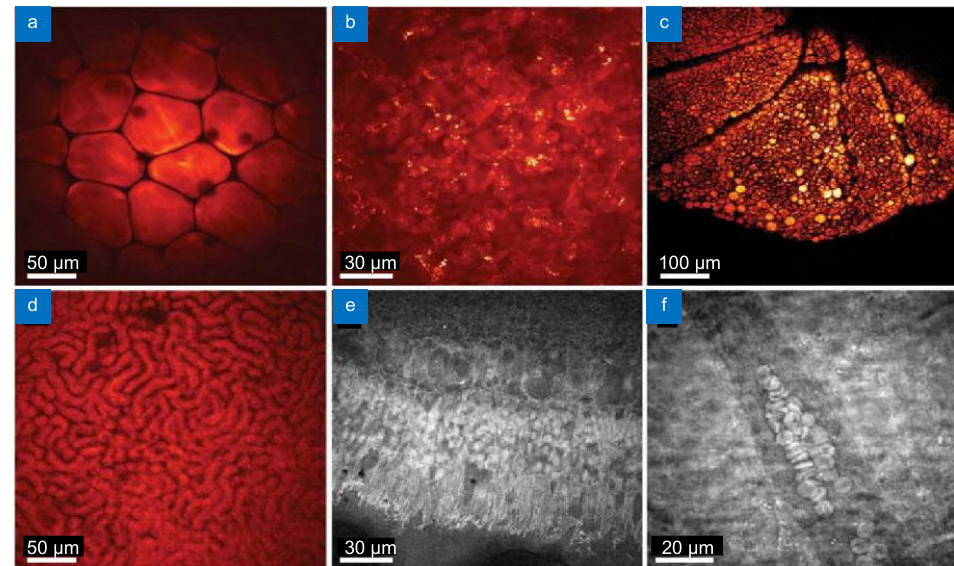
Fig. 7 | Coherent anti-Stokes Raman scattering imaging of tissues with CH 2 contrast. Image of ( a ) white adipose tissue in mouse omentum majus, ( b ) mouse lung tissue with alveoli, ( c ) adipocyte covered mouse kidney surface, ( d ) mouse kidney with renal tubules, ( e ) bovine retina cross section, and ( f ) human retina at the retinal surface. Figure reproduced from ref. 172 , Annual